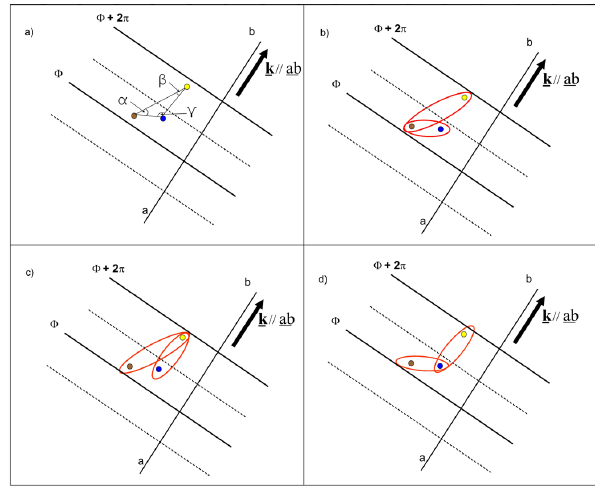
Fig. 3. Part A of the geometrical description of the determination of the real horizontal wavelength. Here the setup of the 3 points ( a ) and the three possible combinations of solving Eq. (2) for different reference points ( b , c and d ) are displayed.